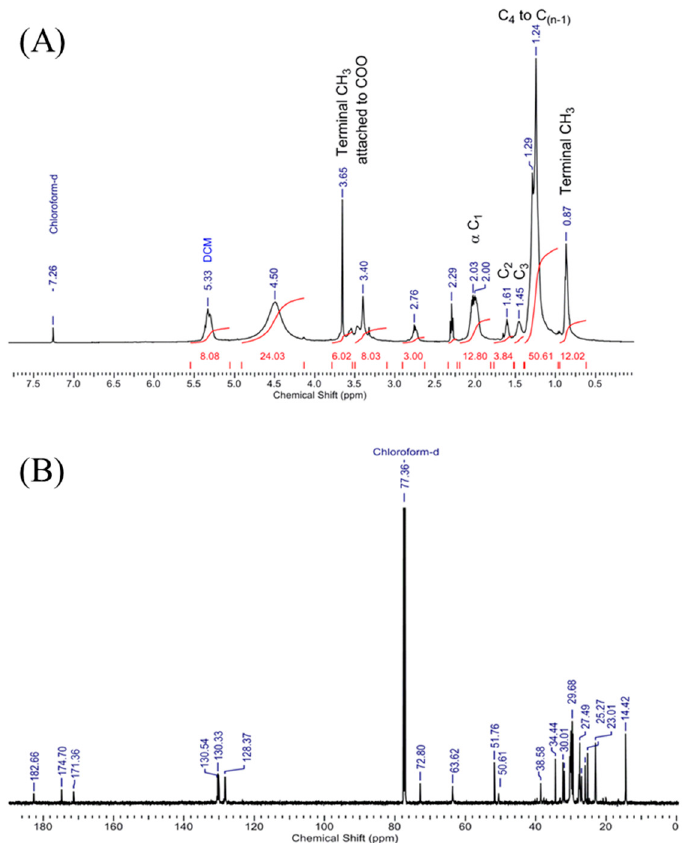
Figure 7. 500 MHz 1 H NMR ( A ) and 100 MHz 13 C NMR ( B ) spectra representing different chemical shift regions of Scenedesmus rotundus-MG910488 biodiesel.